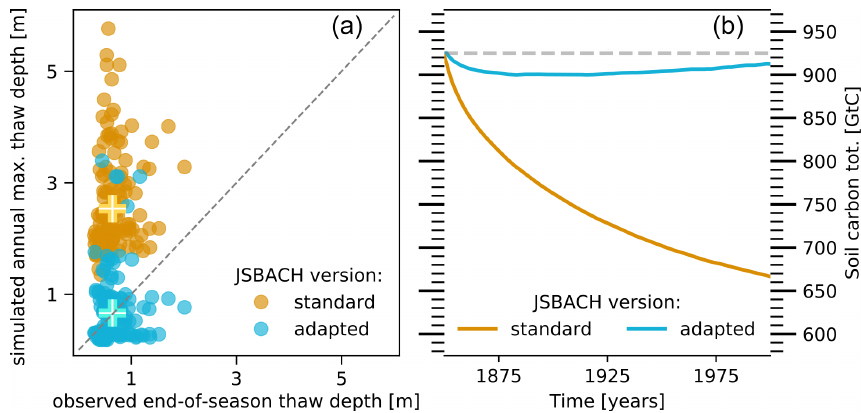
Figure 1. JSBACH model – standard and adapted version. (a) Correlation between simulated annual maximum and observed end-of-the- season thaw depths for the sites of the Circumpolar Active Layer Monitoring (CALM; Brown et al., 2000) programme that are located in the simulated permafrost domain (Fig. 3). Brown dots indicate the maximum thaw depths simulated with the JSBACH standard-model version, while blue dots refer to the adapted version used in the present study. The CALM dataset encompasses the period from 1990 to present. However, this is not the case for all the included sites, and the individual dots show the mean over the period covered by data at a specific site. Crosses show the average over all sites for the respective model versions. Finally, it should be noted that the simulations were performed with the soil properties at the standard resolution (1 . 9 ◦ × 1 . 9 ◦ ) and with atmospheric conditions from a historical simulation with the MPI-ESM, which may be different from the actual soil properties and meteorological conditions at the specific sites. (b) Simulated soil carbon in the permafrost domain during the historical period. The brown line refers to the standard JSBACH model, while the blue line shows the simulation with the adapted version. The grey dashed lines show the observation-based soil carbon stocks (Fig. 4e), with which the simulations were